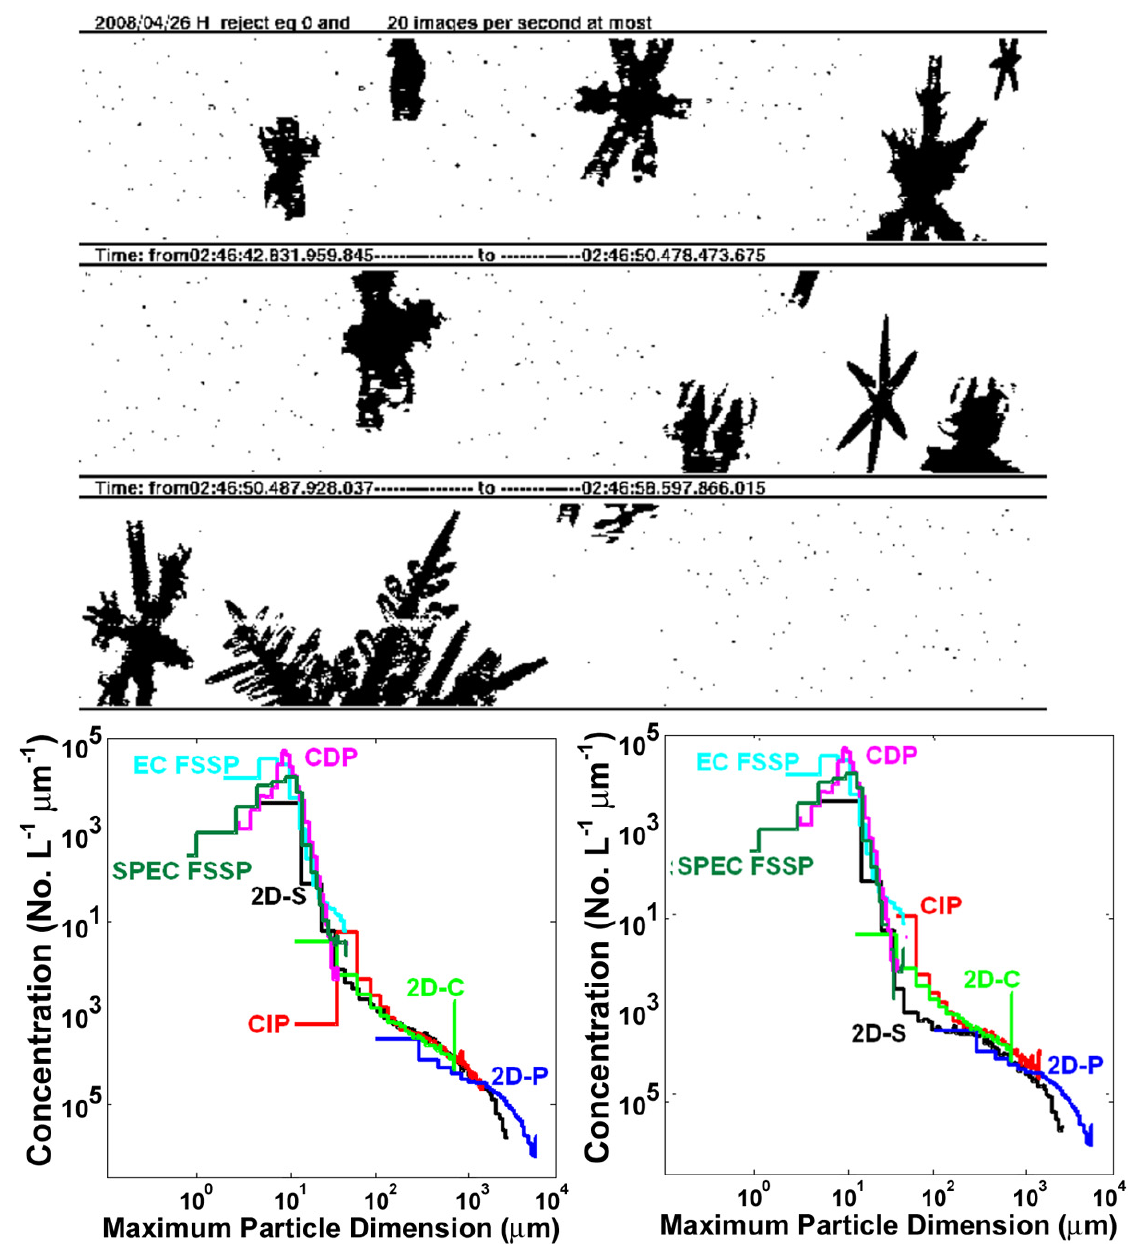
Fig. 11. As in Fig. 10, except data were collected in the mixed-phase region of the same Arctic cloud from 02:48:40 to 02:48:53UTC, Figure 11. As in Fig. 10 , except data were collected in the mixed-phase region of the same 26 April Arctic cloud from 02:48:40 to 02:48:53 UTC on 26 April 2008.